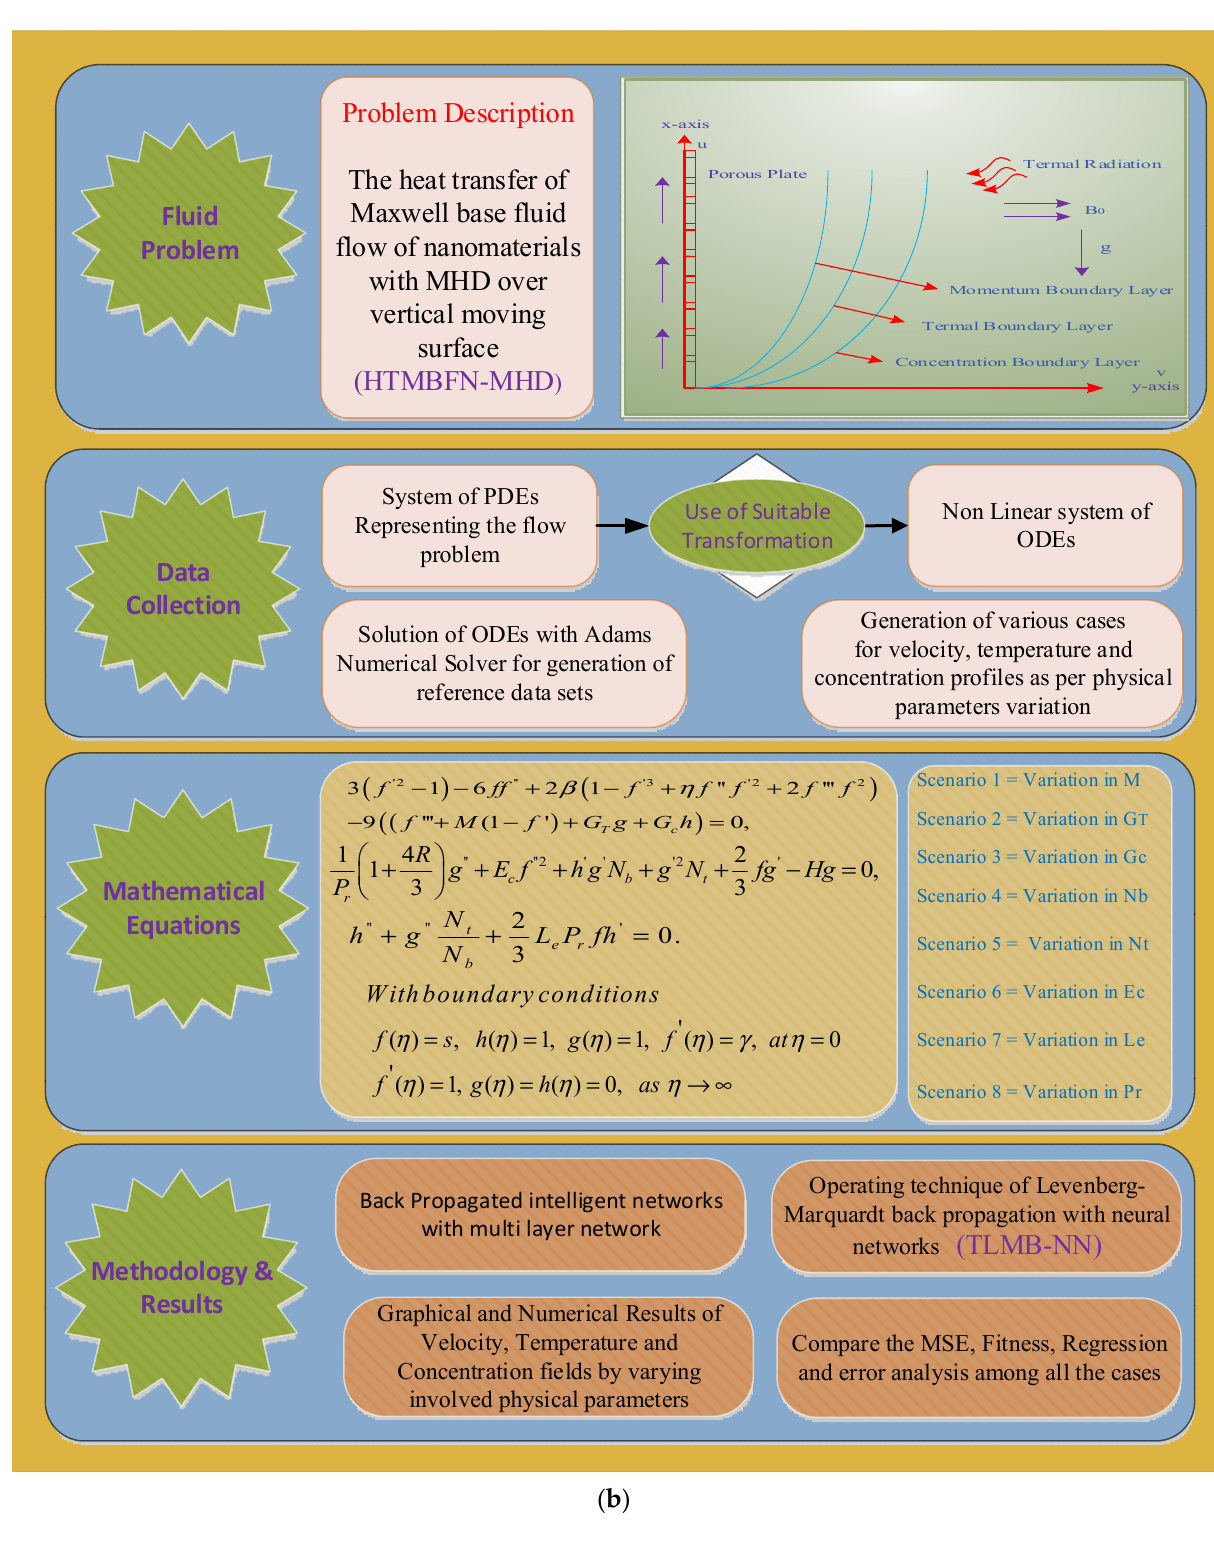
Figure 3. ( a ) Configuration of a particular neuron paradigm and ( b ) overall working flow chart. For fixed values of 𝛽 (cid:3005) = 0.5, 𝑅 = 0.6, and H = 0.3 are exercised for the variation of distinct parameters M ,